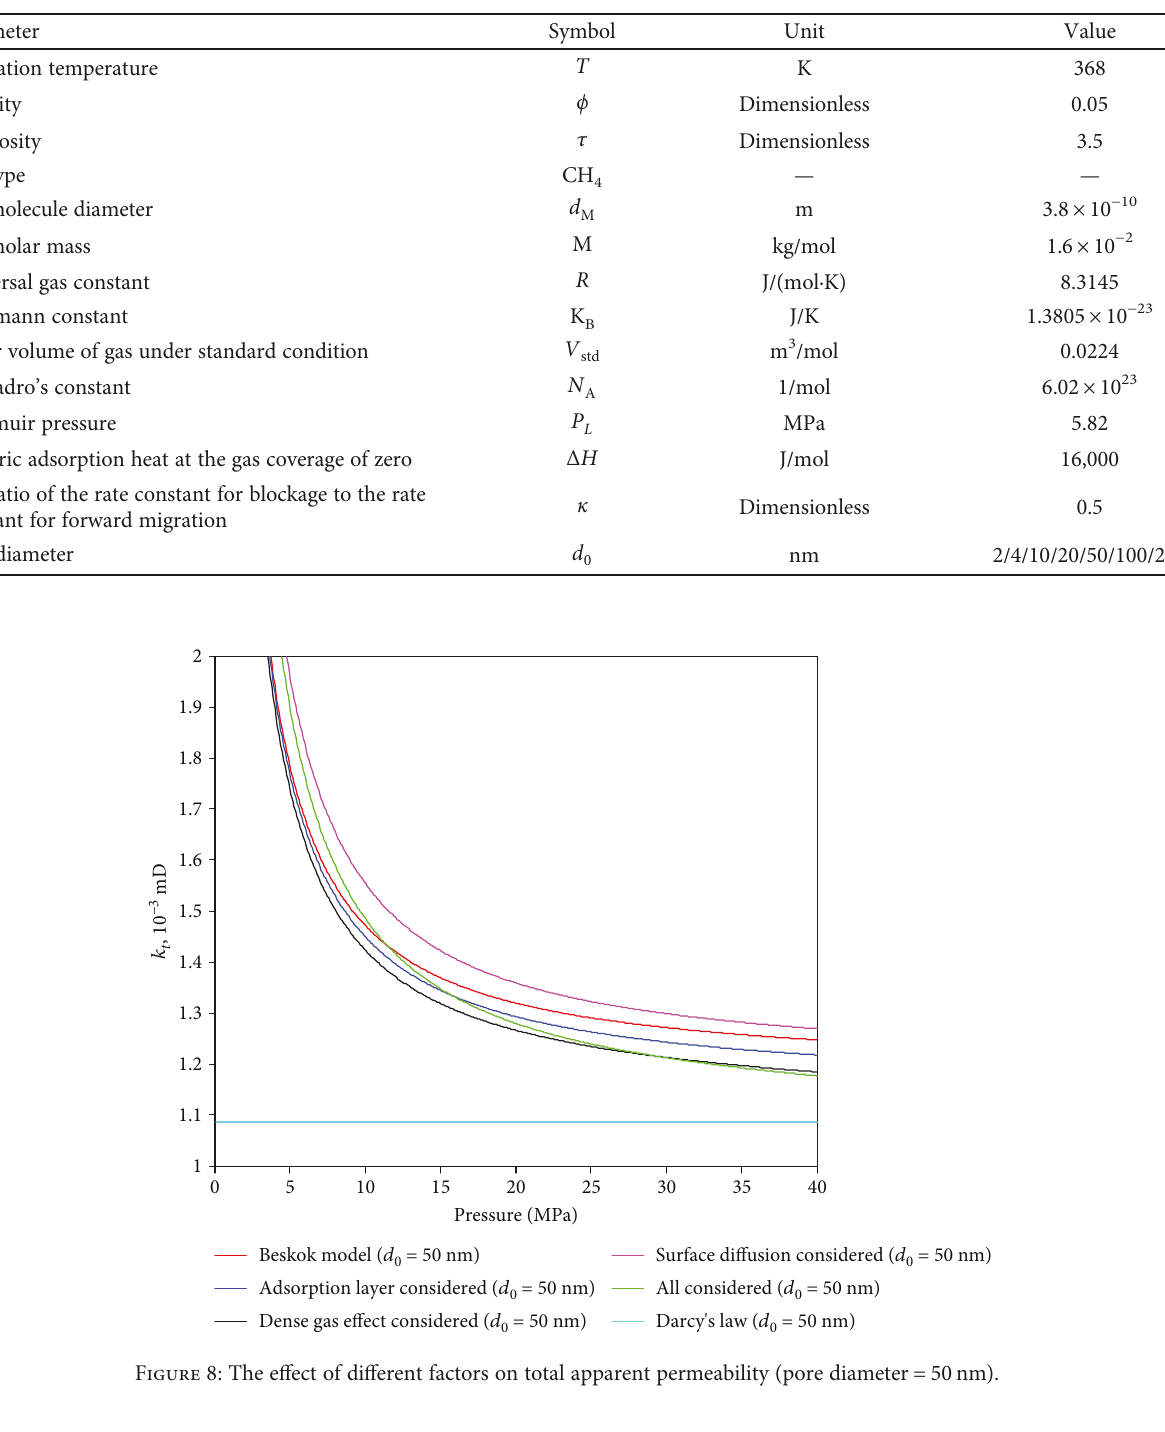
Table 2: Parameters for modeling results and